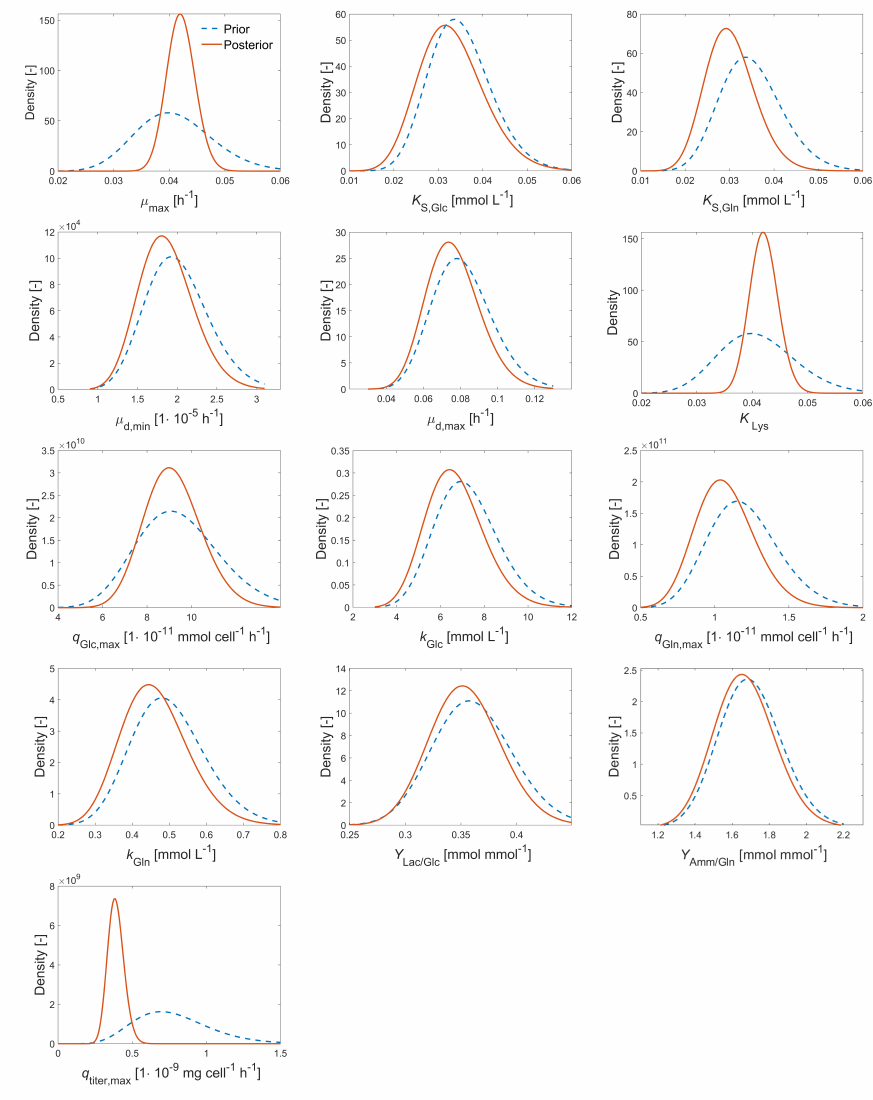
Figure 5. Earlier derived (a priori) parameter distributions (before parameter estimation, blue dashed Figure 5. Prior parameter distributions (before parameter estimation; blue dashed lines) and posterior lines) and posterior parameter distributions (after parameter estimation, red solid lines) of estimated parameter distributions (after parameter estimation; red solid lines) of estimated model parameters model parameters of the process model presented in Table 2 based on experimental data from of the process model presented in Table 2 based on experimental data from cultivation in 500 mL cultivation in 500 mL (TubeSpin 600™ bioreactor) with a cultivation time of 8 (TubeSpin 600 TM bioreactor) with a cultivation time of 8 days.